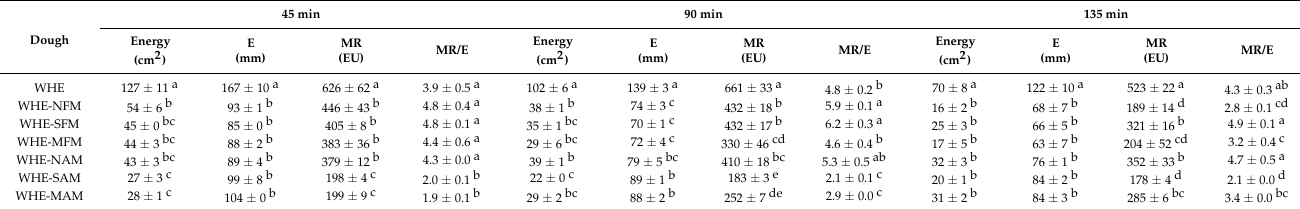
Table 3. Extensogram properties of